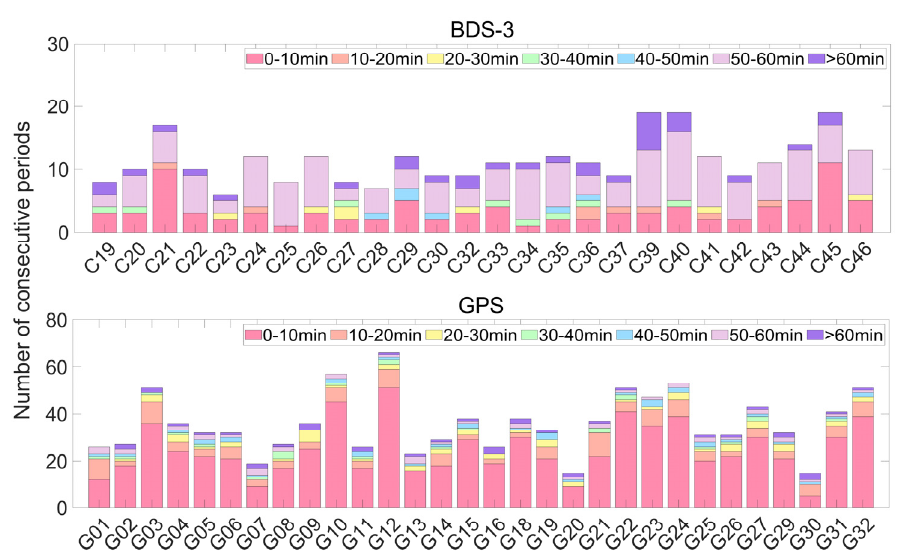
Figure 5. Number of consecutive periods for clock arcs of the BDS-3 and the GPS satellites with different lengths of time on DOY 192 in 2022. Different colors represent different continuous time periods.